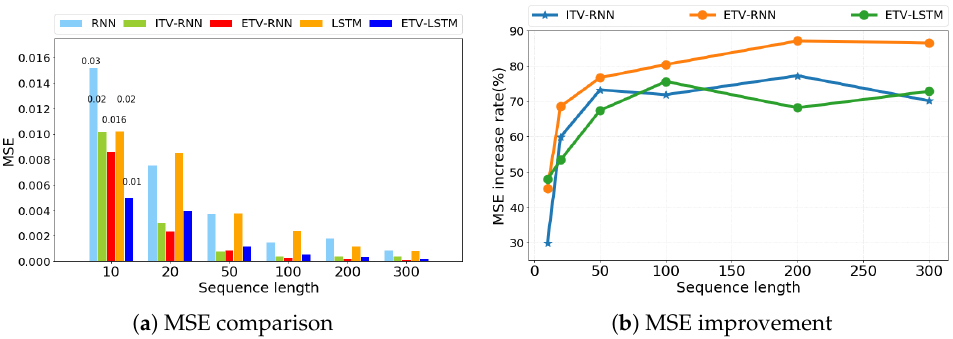
Figure 5. The impact of different sequence lengths from simulation data on model performance (RNN, ITV-RNN, ETV-RNN, LSTM, ETV-LSTM).